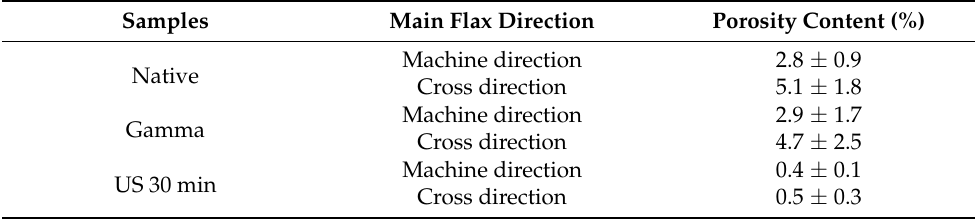
Figure 9. SEM observations of non-woven composites ( a ) Native; ( b ) Gamma; ( c ) US 30 min. Table 3. Porosity content of the non-woven composites according to the card machine orientation.